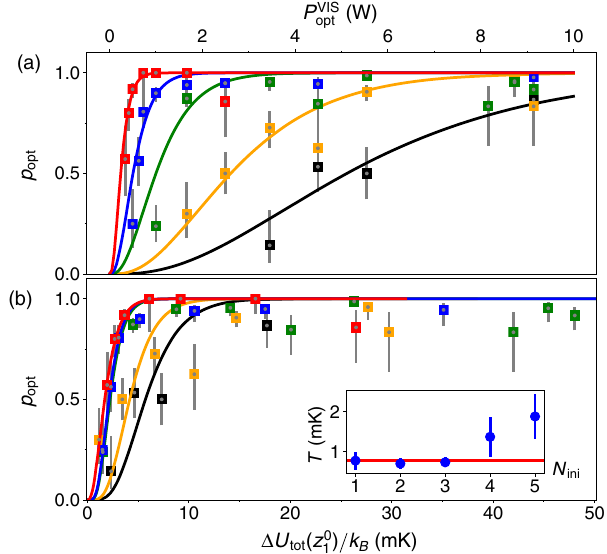
FIG. 3. Measuring the temperature of multiple ions in the single-beam VIS dipole trap. (a) We measure the trapping ¼ 1 … 5 ions as a function of P VIS probability p for N opt ini opt (red, blue, green, yellow, and black squares). The solid lines indicate fits with the radial-cutoff model [29], which relates the trapping probability and finite trap depth for atoms or a single ion > 1 ions to their temperature. We observe that trapping N ini requires increased laser power. Still applying the single-particle model yields a ten times larger temperature or decreased trap depth. In (b), we reanalyze the data shown in (a), taking into account the axial extent of the ensemble, electrostatic fields, and mutual Coulomb interaction to calculate the local radial trap ð z 0 Þ . depth at the axial positions of the outermost ions Δ U 1 ;N tot ini Solid lines depict fits assuming the altered radial-cutoff model ð z 0 Þ (see text). We obtain temperatures of T ¼ for Δ U N i tot ini ð 0 . 7 (cid:2) 0 . 1 Þ mK for N ≤ 3 , as well as T ¼ ð 1 . 3 (cid:2) 0 . 5 Þ mK 4 ini and T 5 ¼ ð 1 . 8 (cid:2) 0 . 5 Þ mK